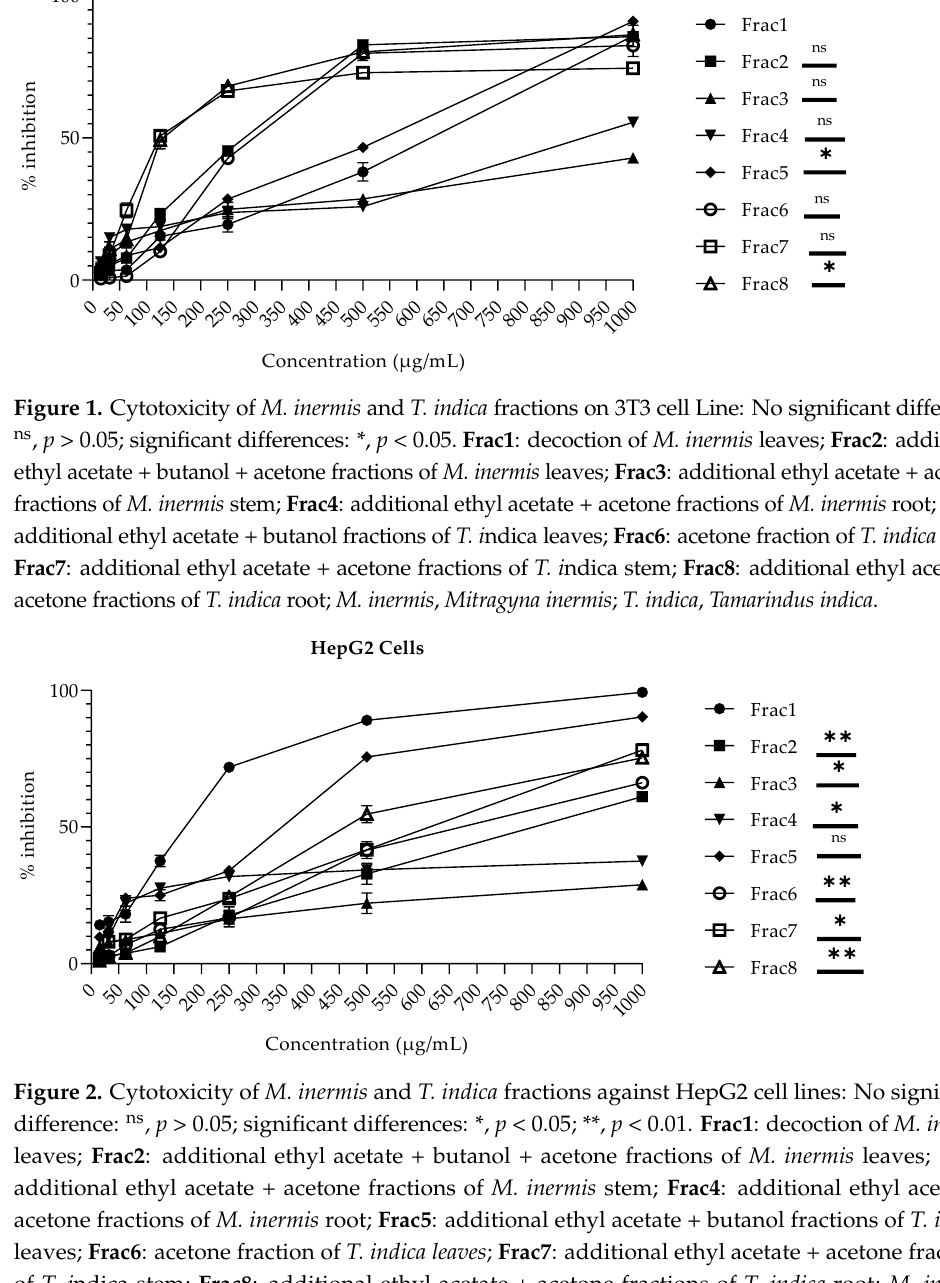
4 of 14 + acetone fractions of M. inermis root; Frac5 : additional ethyl acetate + butanol fractions of T. i ndica leaves; Frac6: acetone fraction of T. indica leaves ; Frac7 : additional ethyl acetate + acetone fractions of T. indica stem; Frac8 : additional ethyl acetate + acetone fractions of T. indica root; M. inermis , Mi- tragyna inermis ; T. indica , Tamarindus indica . 2.2. Cytotoxicity Profile of Mitragyna inermis and Tamarindus indica Fractions in HepG2 and NIH-3T3 Cells M. inermis and T. indica fractions were evaluated for their cytotoxicity in human hepa- tocellular carcinoma (HepG2) cells at the concentration range from 15 – 1000 µg/mL by em- ploying an MTT-based colorimetric assay. The cellular toxicity of these fractions was also evaluated against a normal fibroblast (NIH-3T3) cell line. It is well known that the liver is involved in the detoxification and metabolism of drugs through the cytochrome P450 (CYP450) pathway. Hence, the withdrawal of various drugs from clinical trial studies is often due to their adverse effects in liver cells [30]. Therefore, it was necessary to deter- mine the toxicological effects of the considered fractions on various cell lines. Further- more, the use of in vitro cellular-based models for toxicological studies has been shown to be a useful and economical approach, as compared to studies based on animal models [30]. The results demonstrated that the degree of the different fractions derived from the respective plants ’ cellular toxicity varied significantly from cell line to cell line. In NIH- 3T3 cells, Frac1 , Frac4 , and Frac5 (with 38.04 ± 3.26%, 25.83 ± 0.30%, and 46.66 ± 0.94% inhibitions, respectively) were found to be non-toxic to a concentration of 500 µg/mL, while Frac3 (with 42.92 ± 1.44% inhibition) was found non-cytotoxic up to a concentration of 1000 µg/mL. In contrast, Frac2 , Frac6 , Frac7 , and Frac8 were found to present a toxic effect at concentrations above 125 µg/mL, as shown in Figure 1. On the other hand, in HepG2 cells, Frac2 , Frac3 , Frac6 , and Frac7 (with 32.86 ± 3.88%, 22.16 ± 3.76%, 41.54 ± 3.06%, and 41.71 ± 1.82% inhibitions, respectively) were found to be non-toxic up to a con- centration of 500 µg/mL, while the fraction Frac4 (with 37.50 ± 1.75% inhibition) was found